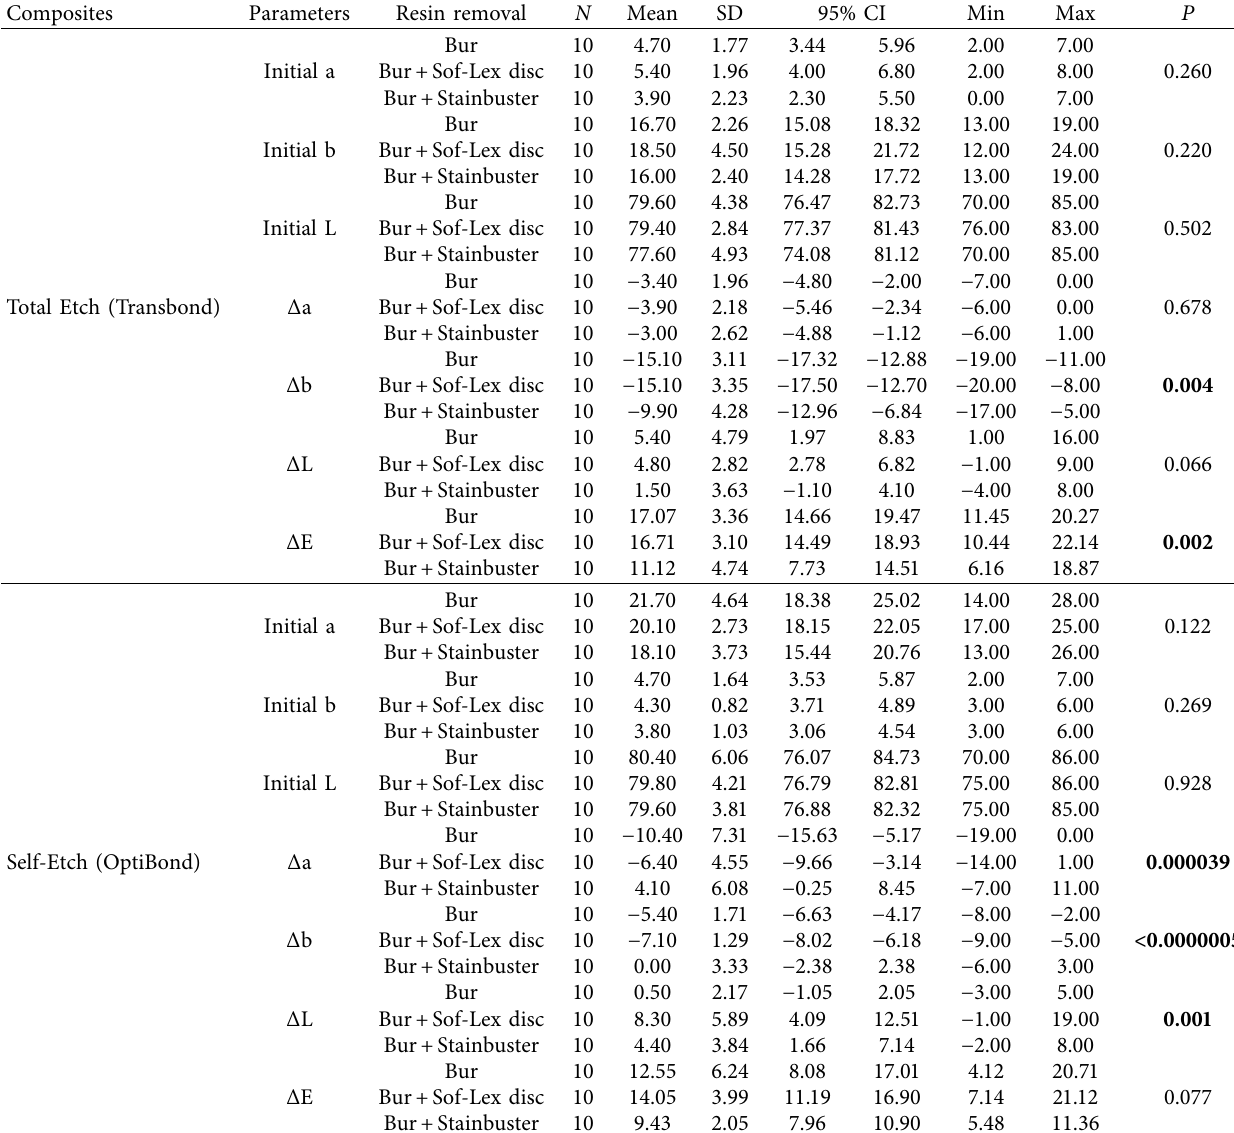
Table 3: Descriptive statistics and 95% CIs for the assessed parameters in each subgroup ( n � 10), as well as the results of subgroup analyses using the one-way ANOVA for the delta